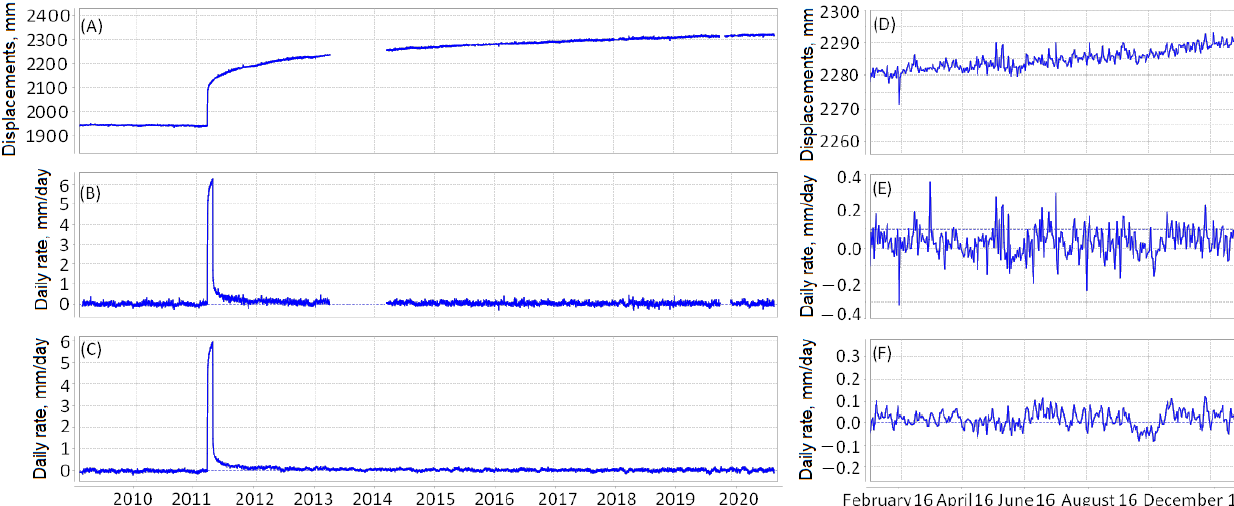
Figure 4. Time series of displacements in the W–E direction of the Japanese receiving station at 35.45 ◦ N and 139.2 ◦ E. coordinates x ( t ) of the station (mm); ( B , E ) time series of daily rates g xk ( t ) of the station (mm/day); ( C , F ) time series V xn ( t ) at the point n of the field V x (mm/day).